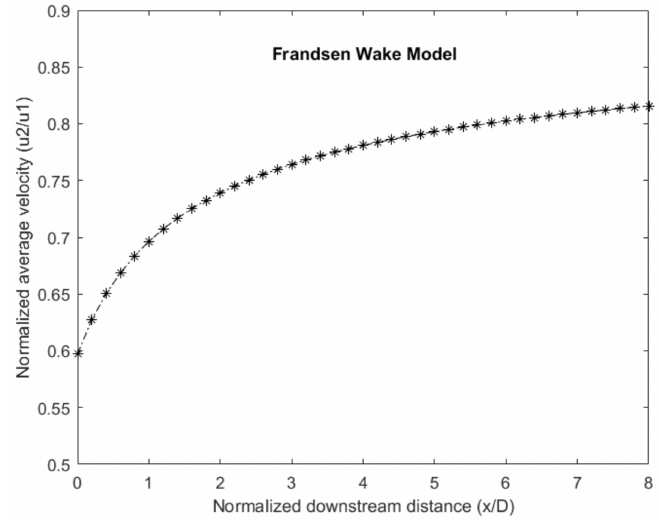
Figure 14. Normalized average velocity profile for the Frandsen wake